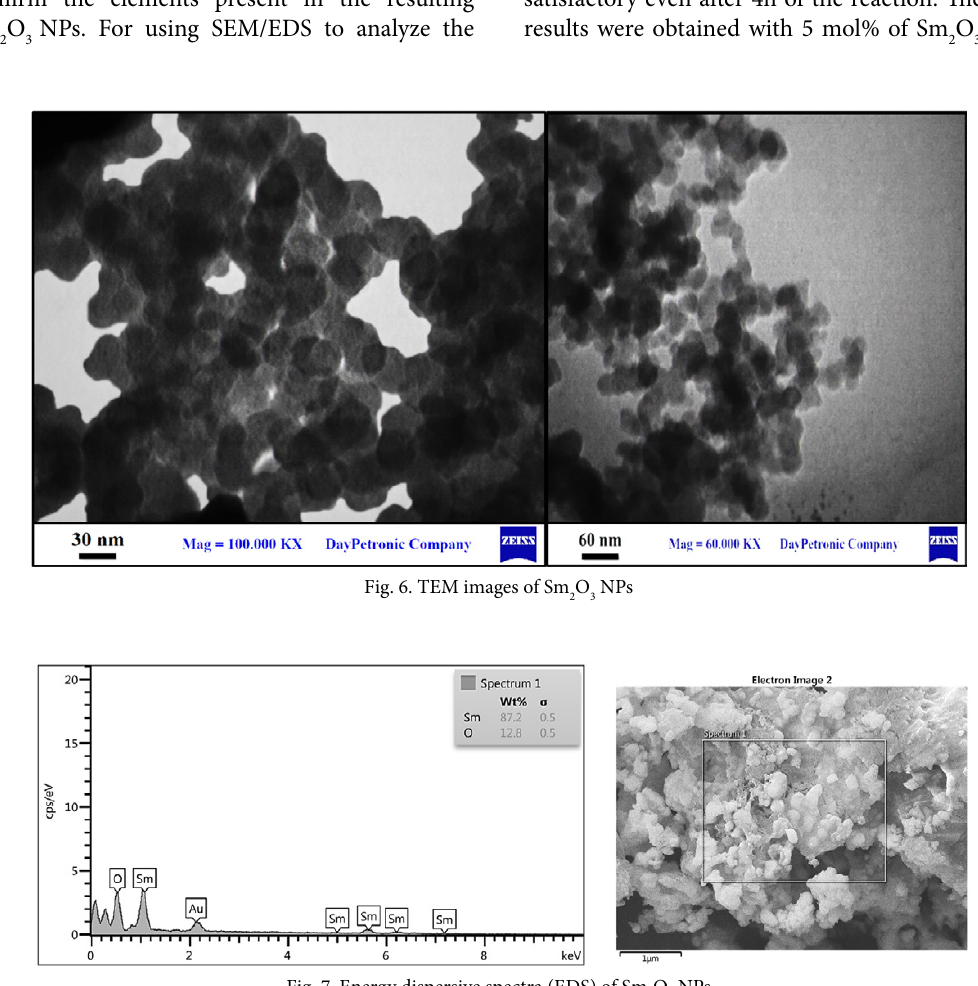
Fig. 7. Energy dispersive spectra (EDS) of Sm 2 O 3 NPs